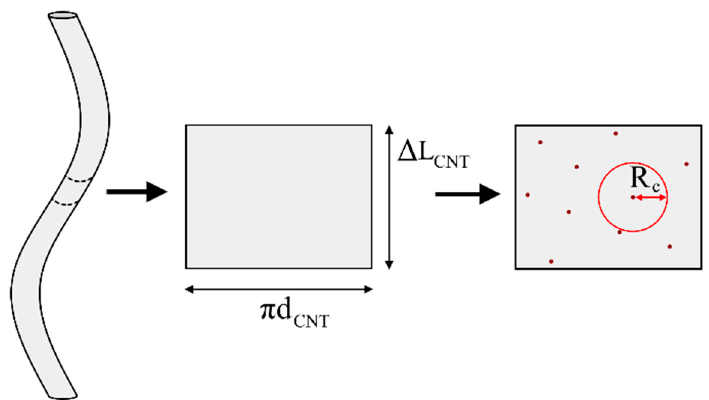
Figure 7. Schematic representation of a cylindrical CNT surface as a rectangular area for the subse- quent loading of platinum nanoparticles.